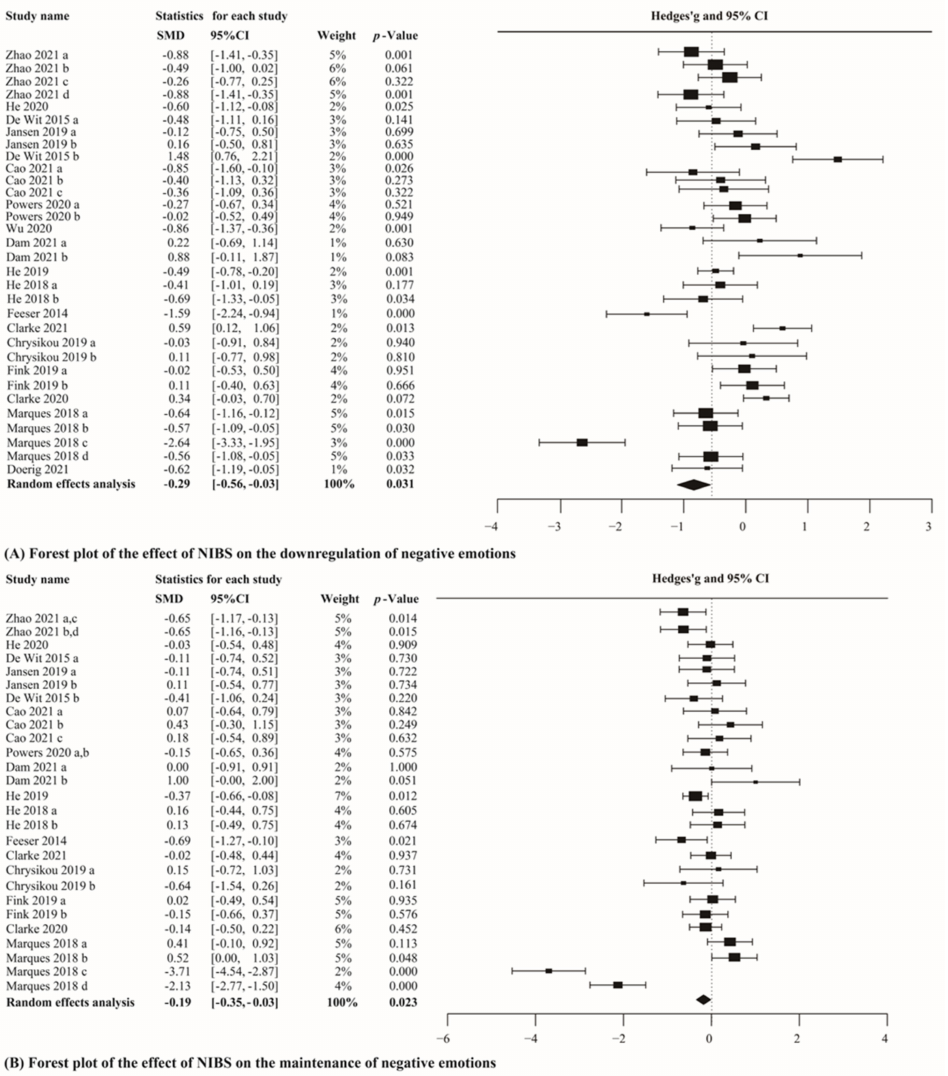
Figure 2. Results of the meta-analyses for overall NIBS studies. (a–d) Different effect sizes from the same study